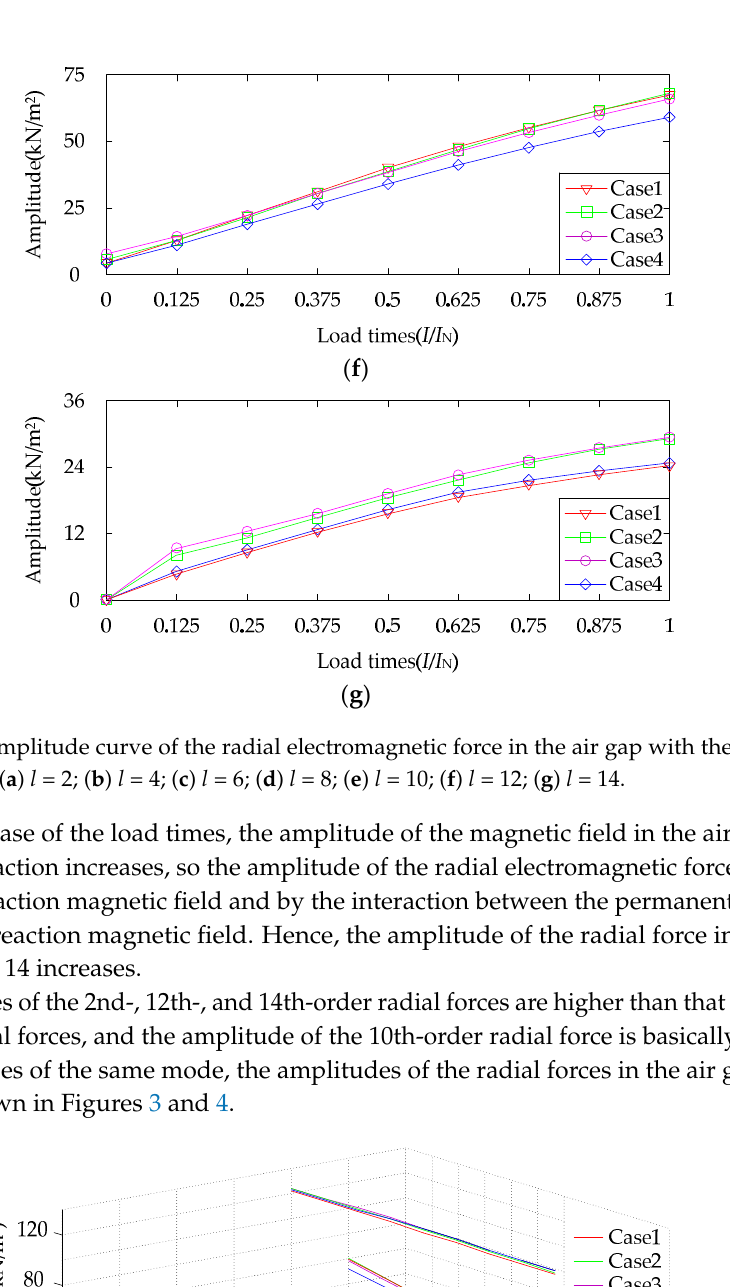
Figure 4. The amplitude curve of the radial electromagnetic force in the air gap with the load times (3D diagrams).